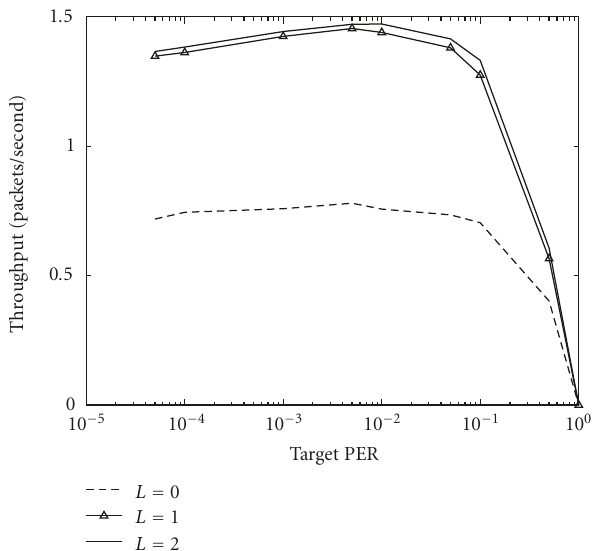
Figure 10: GMDP-based AC polices: throughput as a function of target PER in which ρ